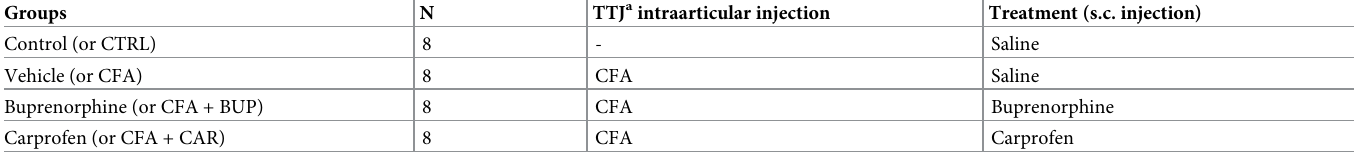
Table 1. Overview of control and experimental